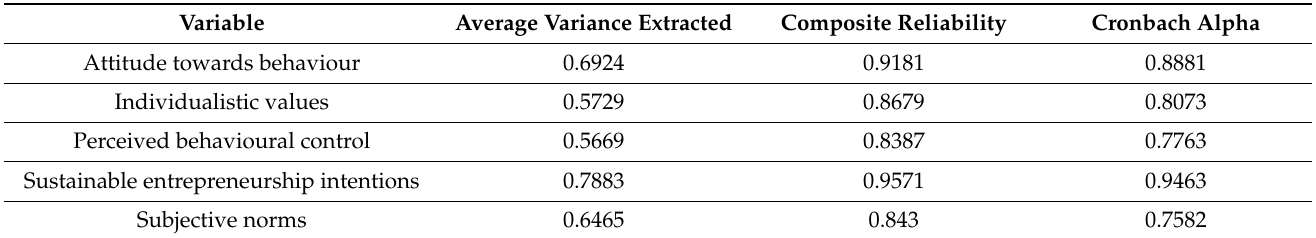
Table 4. Quality criteria.